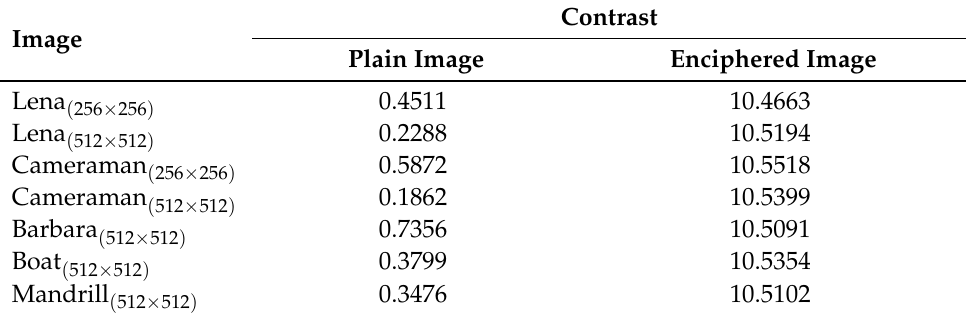
0.29, c 2 = 0.9, x 0 = 2.10, y 0 = − −